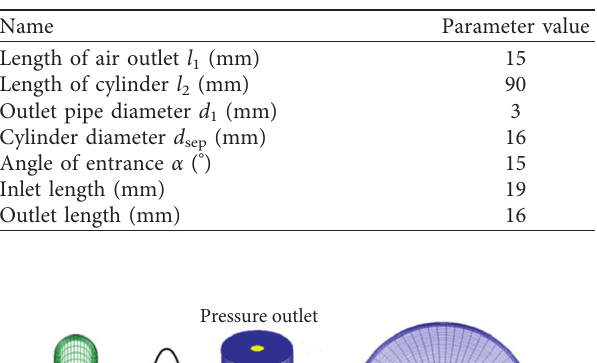
Figure 4: Structure diagram of separator. Table 1: Structure parameters of separator.